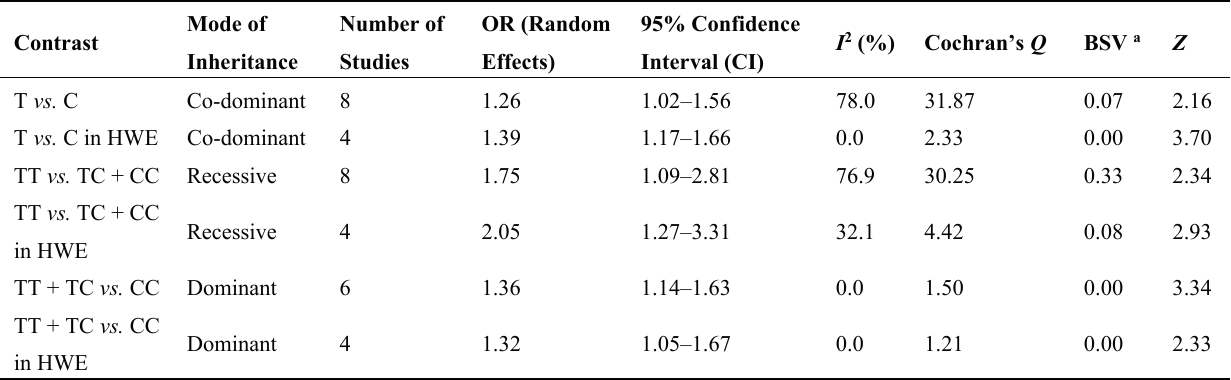
Table 3. Univariate meta-analysis for the 226 C>T (Ala57Val) polymorphism of the CD24 gene with multiple sclerosis.